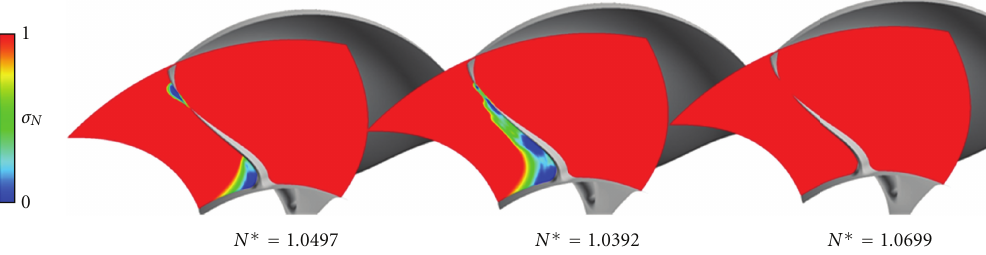
Figure 12: Computational results, local cavitation number, plotted on constant axial cut-through rotor solution at approximate rotor exit, Q ∗ = 0 . 825. Results at each of three conditions of interest, N ∗ = 1 . 0497 and 1.0392 in breakdown and 1.0699 prior to